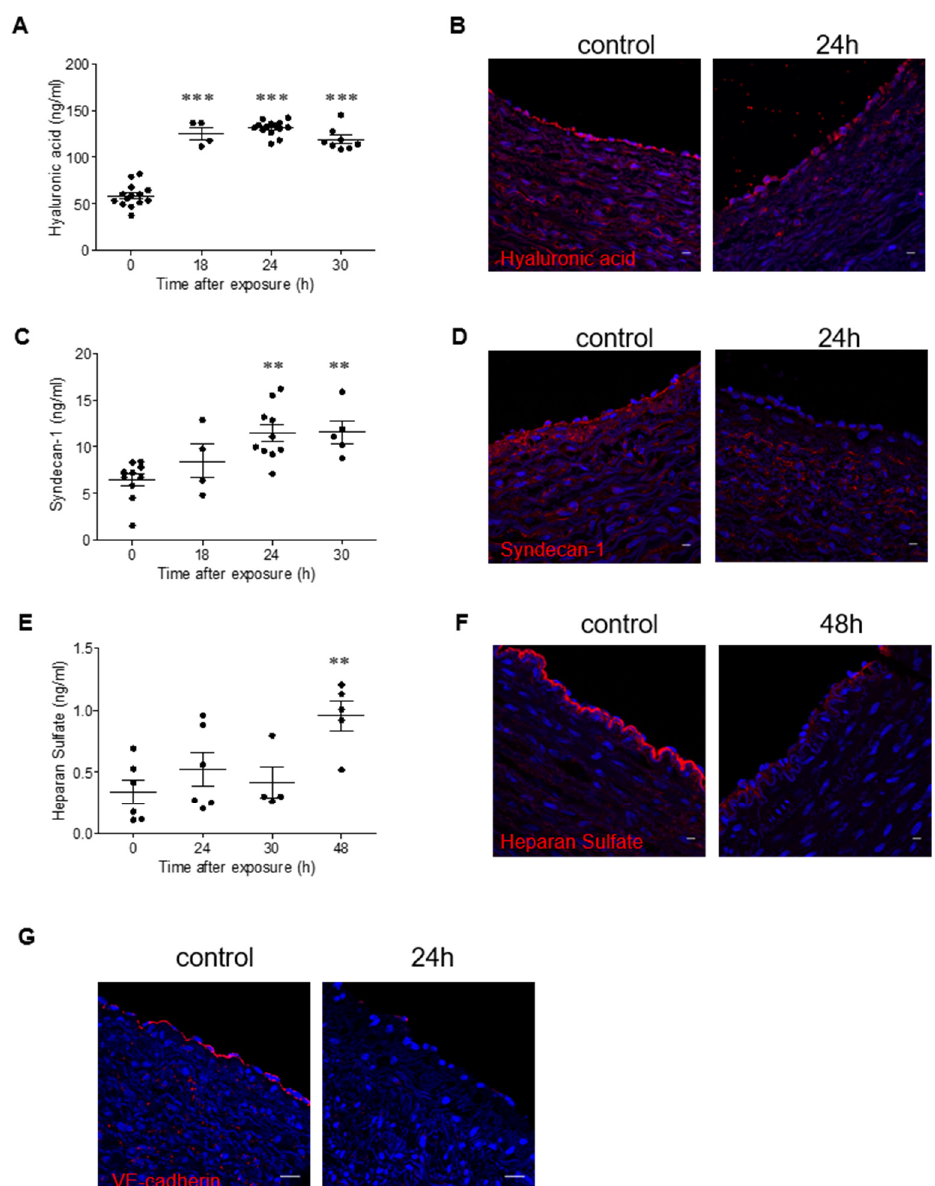
Figure 5. Shedding of the glycocalyx in ricin-intoxicated swine. ( A , C , E ) Circulating levels of HA ( A ), syndecan-1 ( C ) and HS ( E ) determined in control animals and in ricin-intoxicated animals at the indicated time points after intramuscular exposure (7.5 µg/kg). Each dot represents an individual pig. ( B , D , F , G ) Immunofluorescence (red) of HA ( B ), syndecan-1 ( D ), HS ( F ) and VE-cadherin ( G ) in the apical side of swine arteries of control animals and of ricin-intoxicated animals at the indicated time points after intramuscular exposure (7.5 µg/kg). The lumen of the vessel is always upwards. Nuclei stained by DAPI appear in blue. Scale bar: 20 µm (representative sections of n = 3 swine/group are shown). The results are depicted as means ± SEM. Statistical analyses were performed by one-way ANOVA followed by Dunnett’s post hoc test. ** p < 0.01; *** p < 0.001.